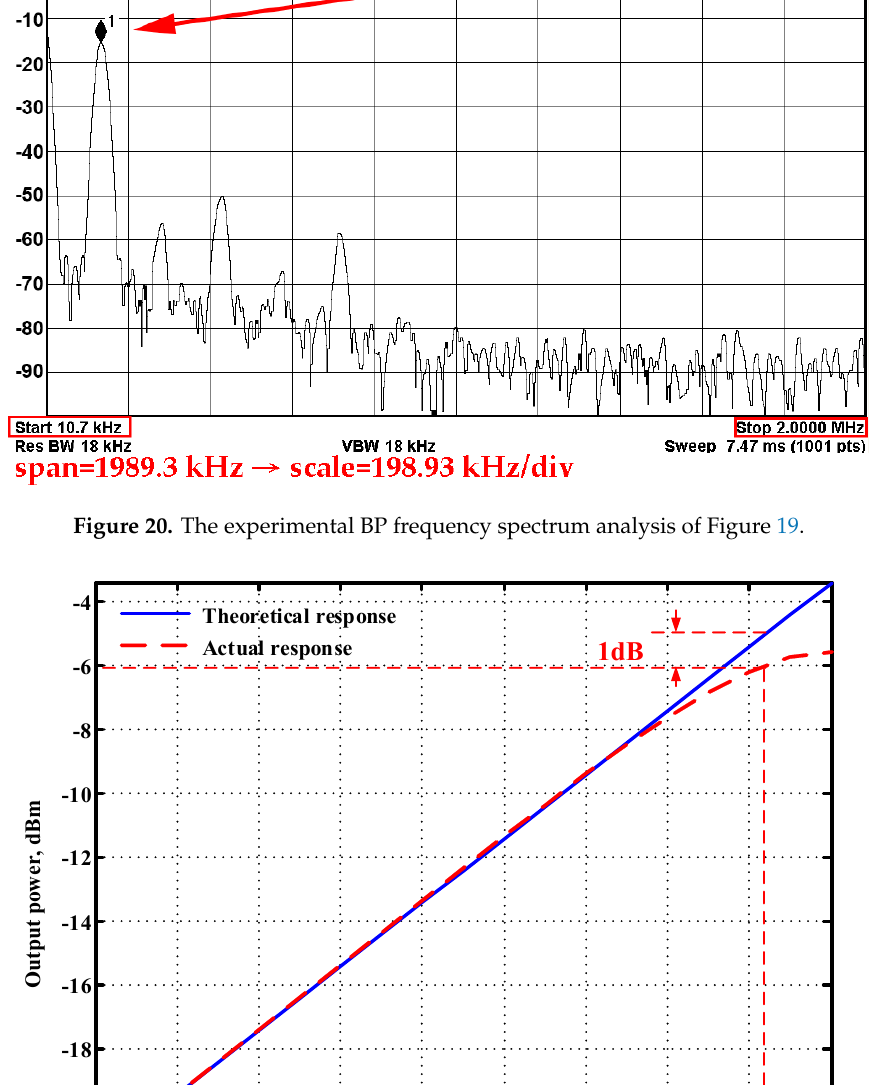
Figure 22. Third-order intercept (TOI) measurement of BP filter.